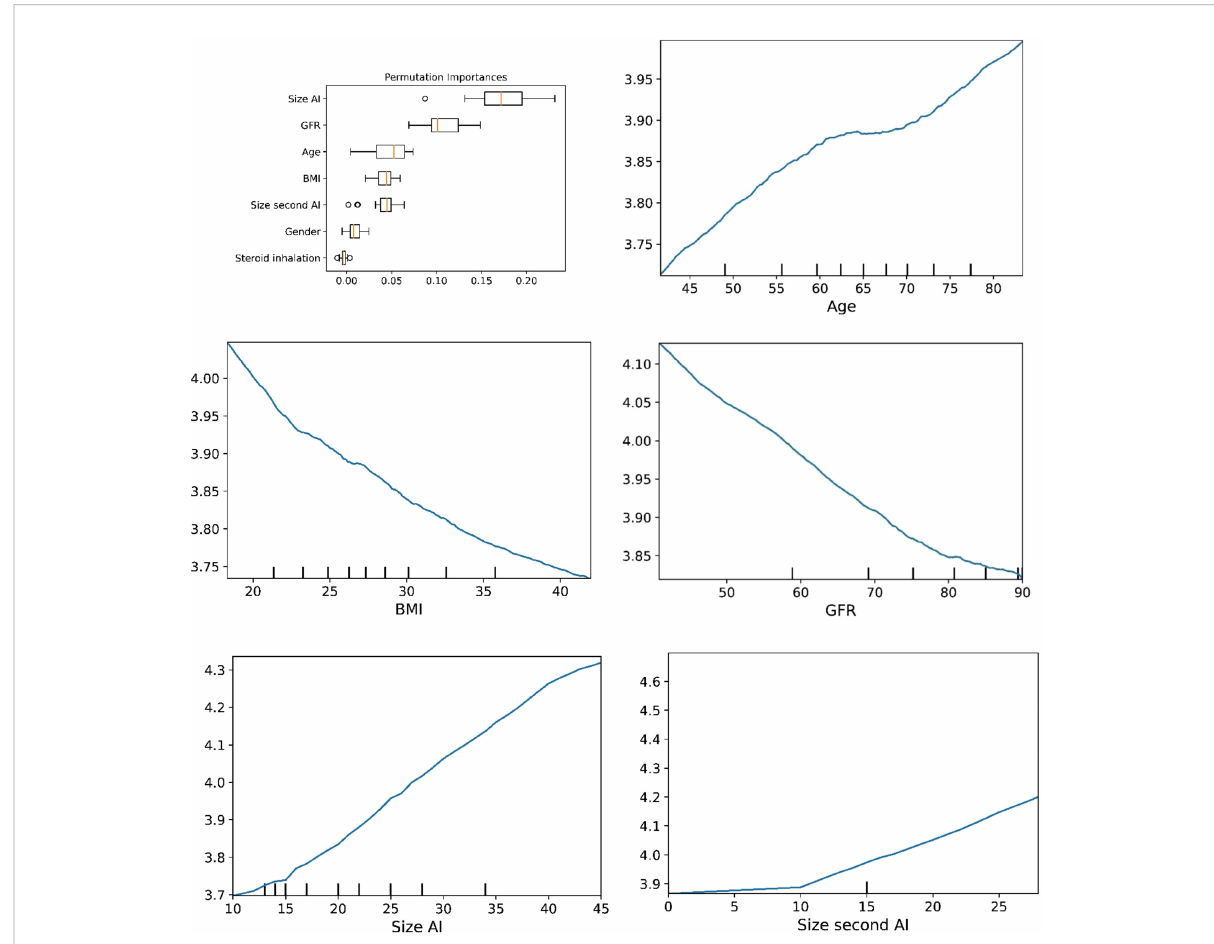
FIGURE 4 The plots for permutation importance and ln-transformed cortisol DST against age, BMI, eGFR, size of AI (in bilateral AI, the size of the largest AI), and size of the second AI using the ML model K-nearest